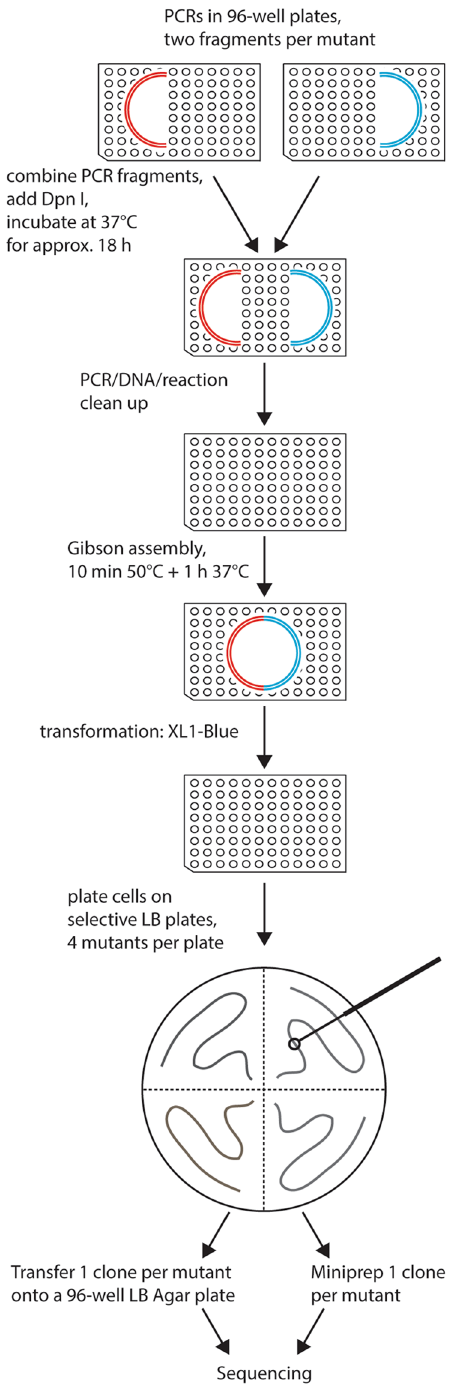
Figure 3. Overview of the mutagenesis technique. Two PCR reactions are done per mutant, in each of them approximately half of the vector is amplified. Two fragments containing one mutation are combined, followed by DpnI digestion at 37 °C overnight. Reaction clean-up is performed to purify DNA fragments, which are then assembled by Gibson assembly reaction. Bacteria are transformed with the resulting circular plasmid and plated on selective LB agar plates. One clone per mutant is sent for sequencing either on a selective LB agar 96-well plate or as purified DNA. All steps excluding the plating of the bacteria are done in 96-well